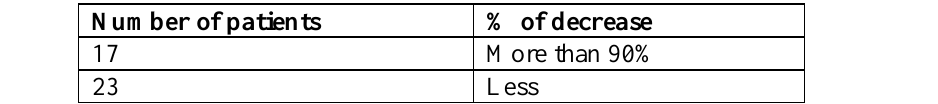
Table 5: shows the percent TSH decrease after 2 months of metformin therapy in 40 patients with high initial TSH.